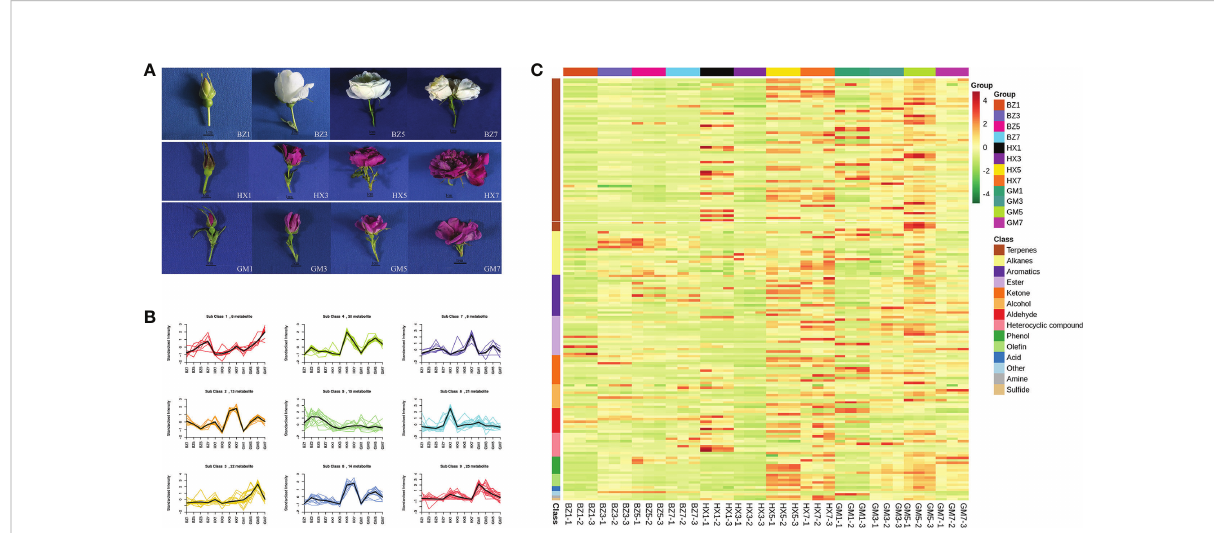
FIGURE 4 Flower development stages, K -means diagram, and heatmap of volatile metabolites in three R. rugosa cultivars. The unit for the fl oral scents is m g/g. (A) Stages of fl ower development for each R. rugosa cultivar. BZ1, fl ower-bud stage of ‘ BaiZiZhi ’ , BZ2, early-blooming stage of ‘ BaiZiZhi ’ , BZ3, full-blooming stage of ‘ BaiZiZhi ’ , BZ4, withering stage of ‘ BaiZiZhi ’ ; HX1, fl ower-bud stage of ‘ Hanxiang ’ , HX2, early-blooming stage of ‘ Hanxiang ’ , HX3, full-blooming stage of ‘ Hanxiang ’ , HX4, withering stage of ‘ Hanxiang ’ ; GM1, fl ower-bud stage of ‘ Guo ’ , GM2, early-blooming stage of ‘ Guo ’ , GM3, full-blooming stage of ‘ Guo ’ , GM4, withering stage of ‘ Guo ’ . The internal bar is 1 cm. (B) Relative contents of standardized differential metabolites in each cultivar. Subclass represents the category number of metabolites with the same change trend. (C) Heatmap of the metabolites in each R. rugosa